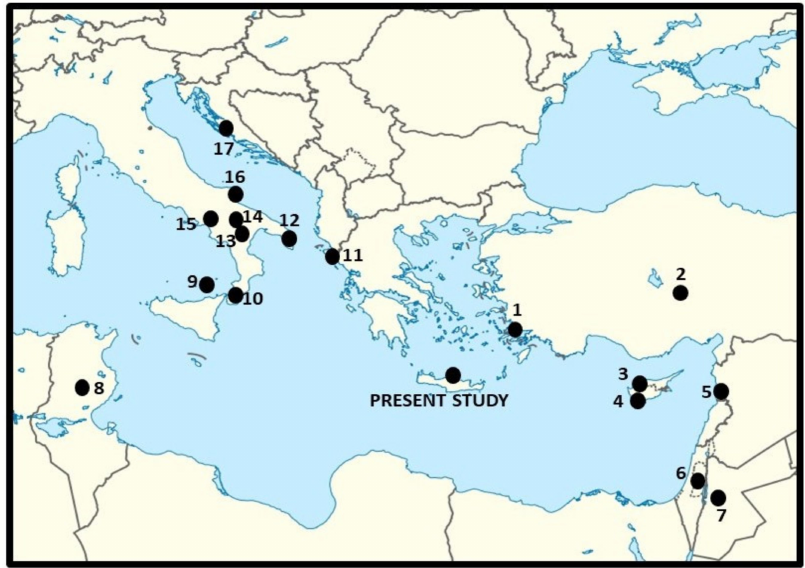
Figure 4. Mediterranean field study sites used in the comparative analysis; number and digits refer to the considered study sites listed in Table